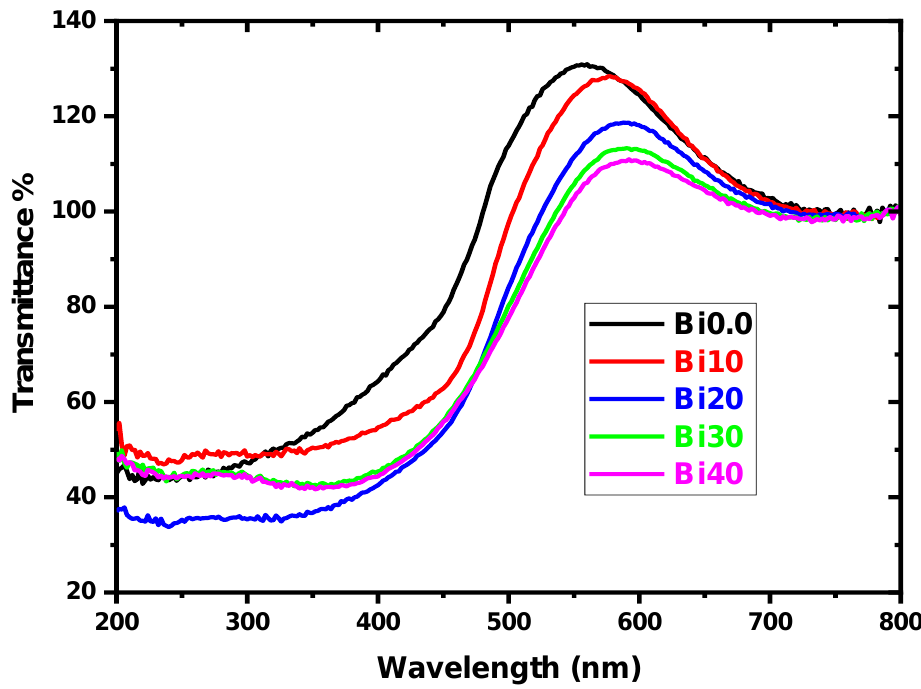
Figure 4. Transmittance of the glass samples versus wavelength for different Bi 2 O 3 content. Table 1. Chemical compositions, density, and molar volume of present glass samples.